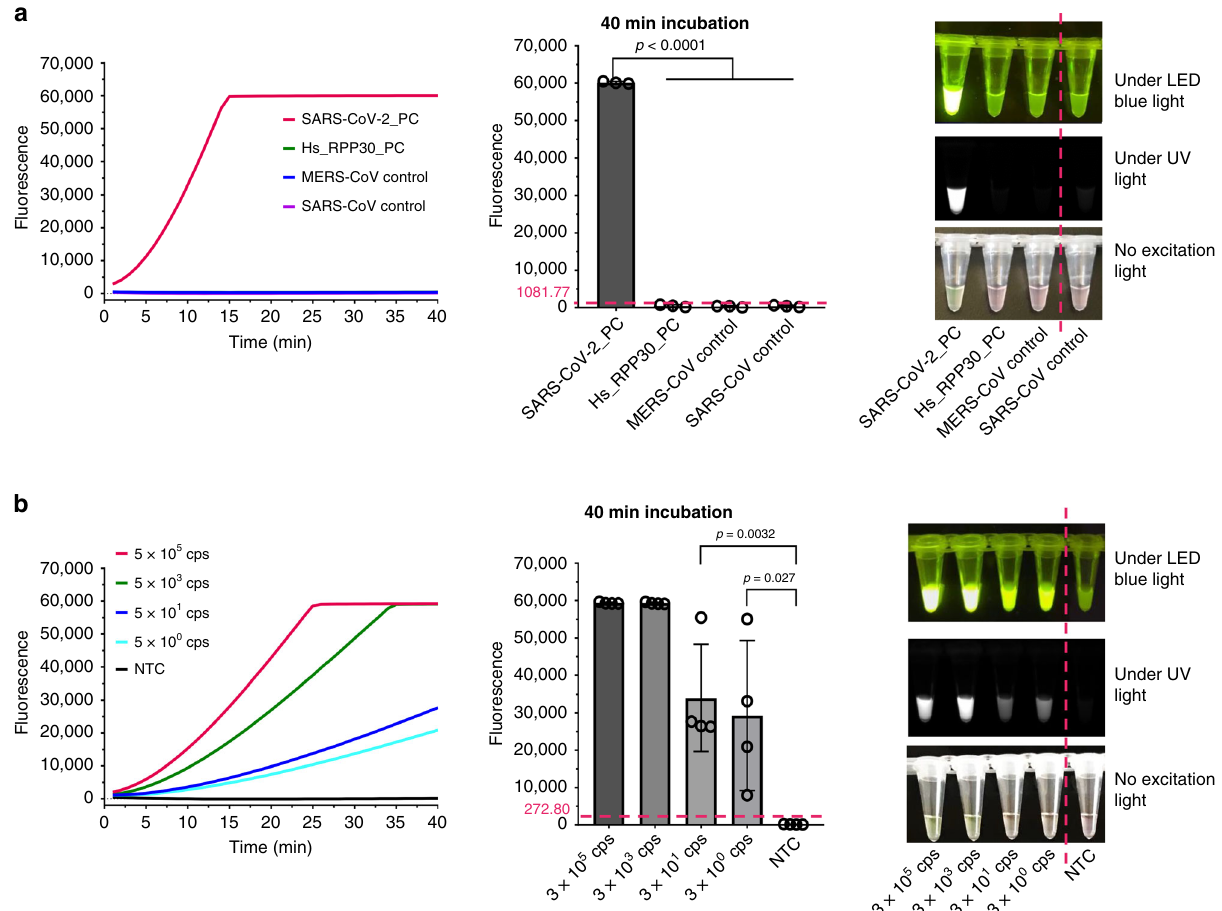
Fig. 3 Speci fi city of AIOD-CRISPR and sensitivity of RT-AIOD-CRISPR for detection of synthetic SARS-CoV-2 N RNA sequences. a Speci fi city of real- time/endpoint AIOD-CRISPR assay for SARS-CoV-2 N detection. Three replicates were run ( n = 3). Source data are provided as a Source Data fi le. b Real- time/endpoint RT-AIOD-CRISPR detection of the tenfold serial dilution of synthetic SARS-CoV-2 N RNA sequences. Four replicates were run ( n = 4). Source data are provided as a Source Data fi le. The horizontal dashed line indicates the cutoff fl uorescence that was de fi ned by the average intensity of NTC plus three times of the standard deviation. NTC, non-template control reaction. Error bars represent the means± s.d. from replicates. The unpaired two-tailed t -test was used to analyze the statistical signi fi cance. Source data is available for a , b